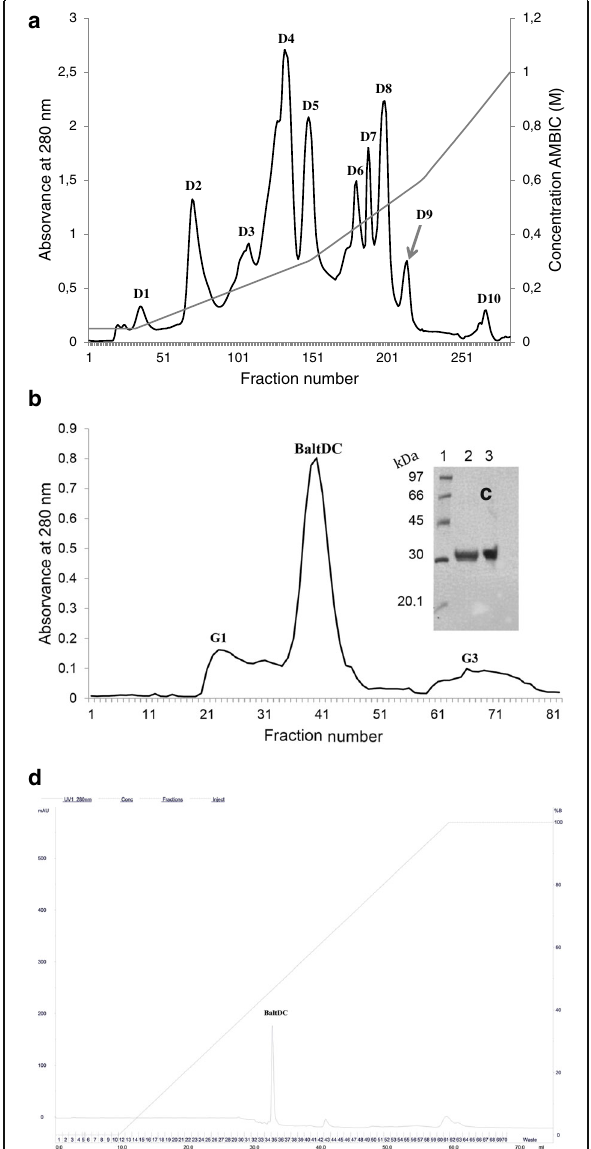
Fig. 1 Purification of BaltDC. (a) Anion-exchange chromatography of B. alternatus crude venom on a DEAE-Sephacel column (2.5 × 20 cm) equilibrated with 0.05 M ammonium bicarbonate (pH 7.8) and eluted with a convex concentration gradient of the same buffer (0.05 – 1 M). (b) Gel filtration on Sephadex G-75 column (1.0 × 100 cm): ninth peak was applied to the column and eluted with 0.05 M ammonium bicarbonate. Fractions of 3.0 mL/tube were collected and the absorbance was read at 280 nm. (c) SDS-PAGE: Lane 1 – standard proteins; lane 2 – BaltDC under non-reducing conditions; lane 3 – BaltDC under reducing conditions. The molecular mass standard proteins used were phosphorylase b (97 kDa), bovine serum albumin (66 kDa), ovalbumin (45 kDa), carbonic anhydrase (30 kDa) and soybean trypsin inhibitor (20.1 kDa). Gels were stained with Coomassie blue R-250, 0.2%. (d) Reverse-phase HPLC on a Source 15RPC ST column (4.6 × 100 mm) equilibrated with 0.1% trifluoroacetic acid (TFA) and eluted with a linear concentration gradient from 0 to 100% of solution B (70% acetonitrile in 0.1%